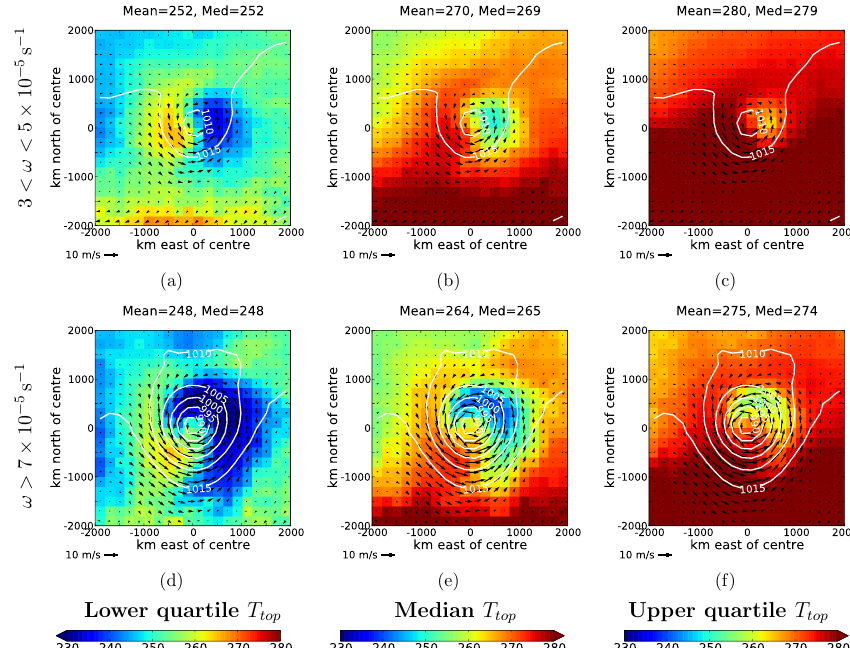
Figure 4: Fig. 4. Similar to Fig. 1, but for Aqua-MODIS cloud top temperature ( T top , K) over the North Atlantic